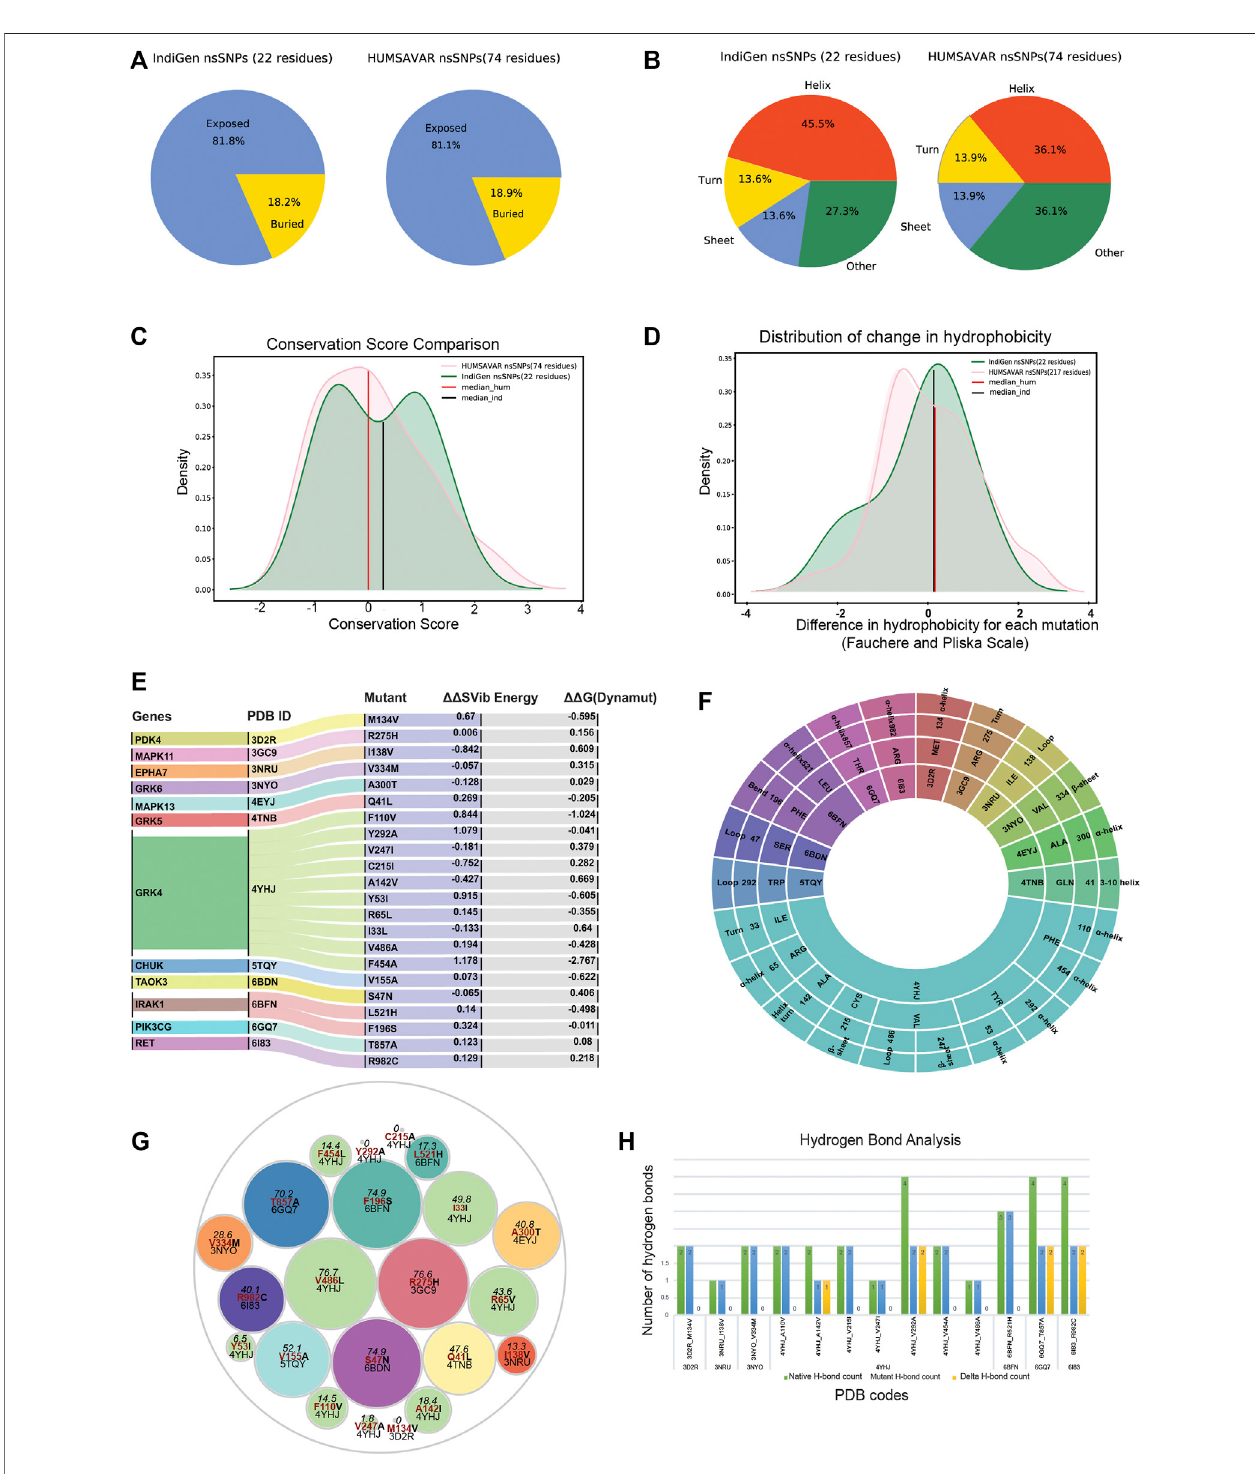
FIGURE 4 | Comparison of structural characteristics of variants in IndiGen and Humsavar data: (A) Solvent accessibility for the variants in both datasets. (B) Secondarystructureinwhicheachofthevariantsoccursinbothdatasets. (C) Conservationscoreand Δ HydrophobicitydistributionofvariantsinHumsavarandIndiGen data. (D) The area under the curve present on the left of − 2 ( Δ Hydrophobicity) belongs to the percentage of residues for which a signi fi cant increase in hydrophobicity afterthemutationwasobservedwhileadecreaseinhydrophobicitywasobservedtheforpercentageofresiduepresentontherightof+2onX-axis. (E) Alluvialplot representingachangeinfoldingenergy(inkcal/mol)( δδ G)andvibrationalentropybyDynamutenergyfor22variants. (F) SunburnPlotrepresentingsecondarystructure assignment done by DSSP for mutant residues. (G) A circle packing plot is showing relative solvent accessibility of mutated residues of 22 variants corresponding to 12 proteins calculated using Naccess. (H) HBPLUS results showing the number of hydrogen bonds made by mutated residue before mutation (green -bar), after mutation (blue-bar), and Δ H-bonds (yellow bars).